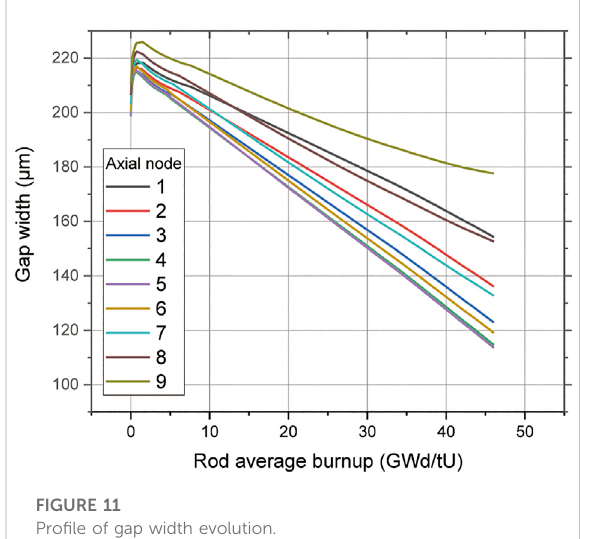
FIGURE 13 Gap conductance of peak power